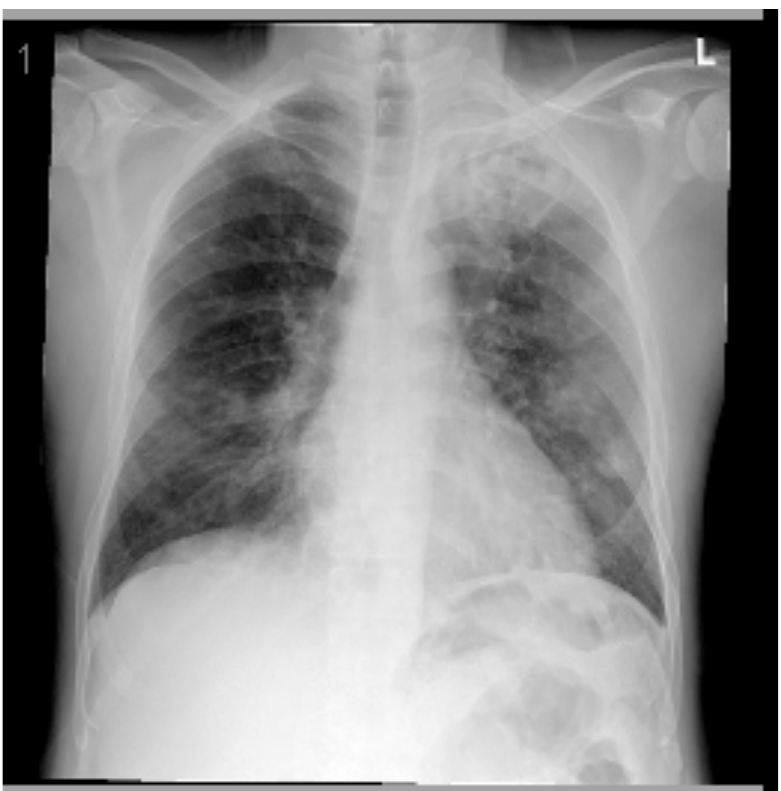
Figure 1. Posteroanterior chest X-ray (CXR) of the first case. The CXR shows bilateral diffuse patchy opacities noted with left upper lung zone consolidation, which could be infectious for clinical correlation and follow-up. Perihilar peribronchial thickening noted. No pleural effusion or pneumothorax. The cardiomediastinal silhouette appears unremarkable.